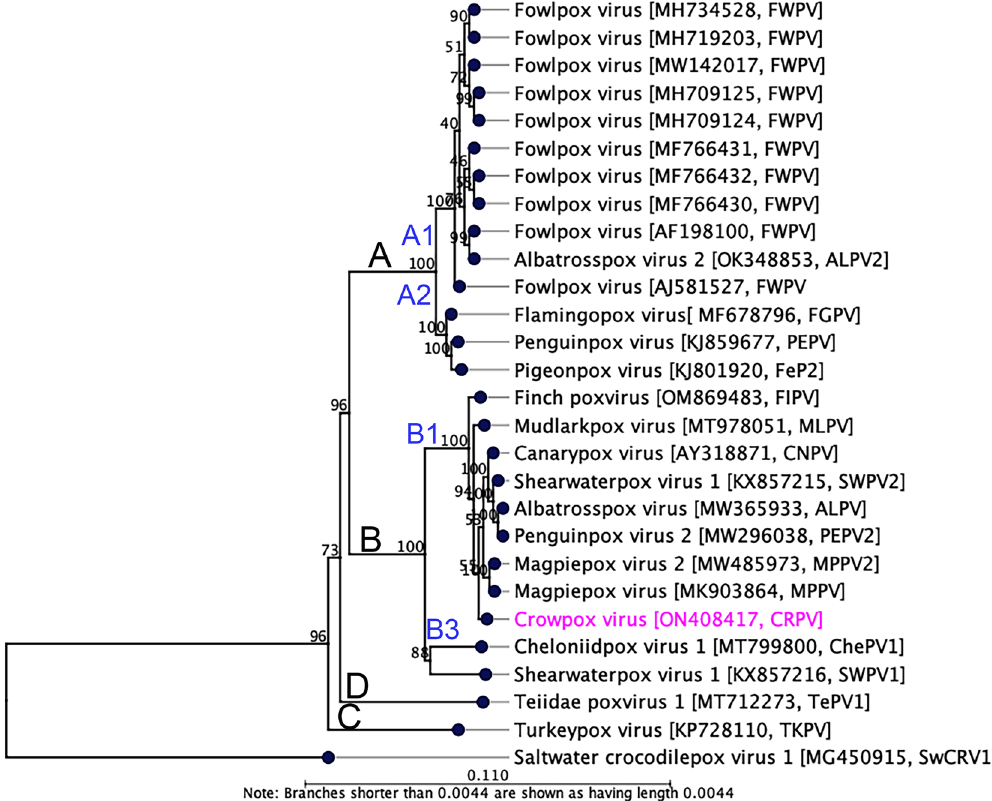
Figure 3. Phylogenetic relationships between CRPV and other chordopoxviruses. A maximum likelihood (ML) tree was constructed from multiple alignments of the concatenated amino acid sequences of the selected nine poxvirus core proteins using CLC Genomics Workbench (version 9.0.1). The numbers on the left show bootstrap values as percentages. The labels at branch tips refer to virus species, followed by GenBank accession numbers and abbreviated species names in parentheses. The position of CRPV is highlighted using pink text. Details of the poxviruses used in the phylogenetic tree are in Table 3. Saltwater crocodile poxvirus 1 (SwCRV1; MG450915) 30 was used as an outgroup. Major clades and sub-clades are designated according to Gyuranecz et al . (2013) 25 .